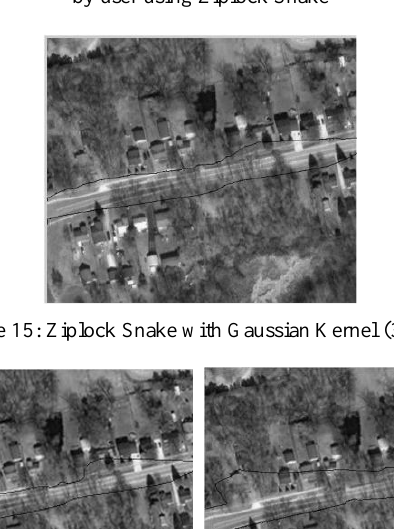
Figure 14: Detection of roads for simple image that is modified by user using Ziplock Snake